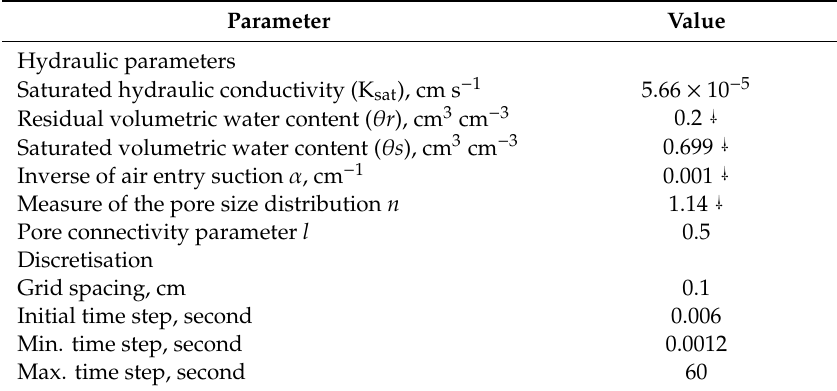
Table 2. HYDRUS model inputs for simulation of the bauxite residue moisture profile.